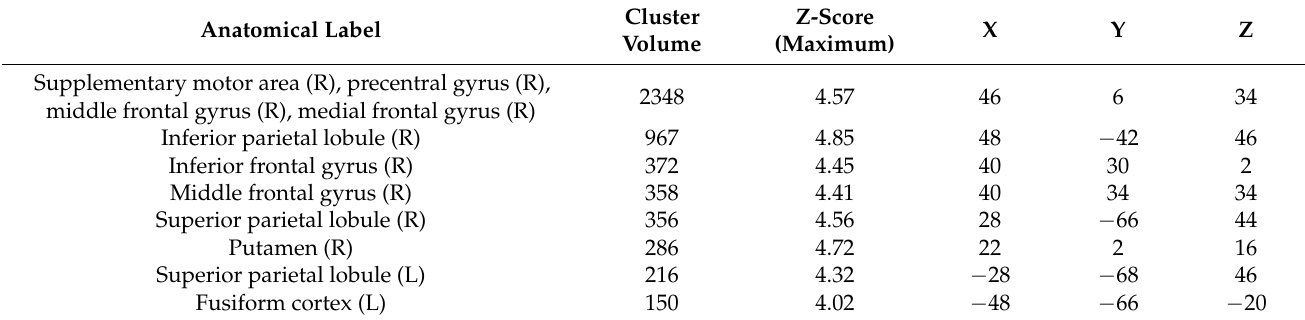
In the fatigued condition, the extent of the suprathreshold clusters was notably smaller. Bilateral activations were seen only in the parietal regions, while in the frontal regions, the activations were mainly observed in the right hemisphere. In neither condition were the activations correlated with the reaction